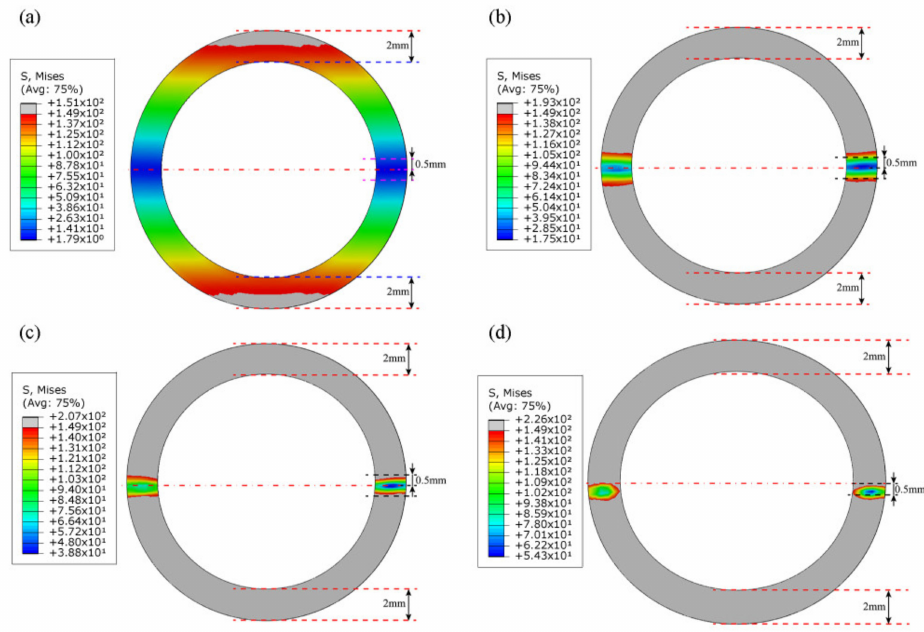
Figure 10. Elastoplastic boundary evolution of SFEM as the bending radius R varies, ( a ) when R = 3600 mm, ( b ) when R = 400 mm, ( c ) when R = 200 mm, ( d ) when R = 100 mm.